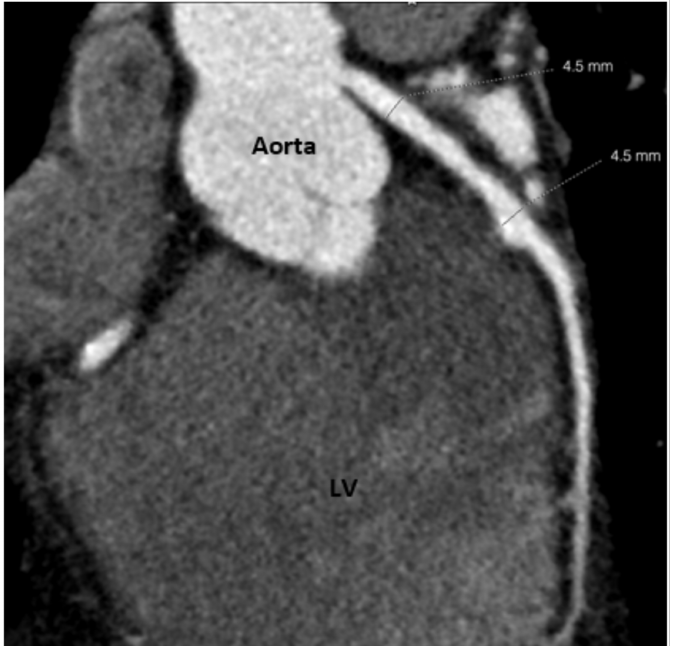
Figure 2. CT angiogram of left anterior descending artery showing persistent mild dilatation of its mid portion and a calcium plague. LV = left